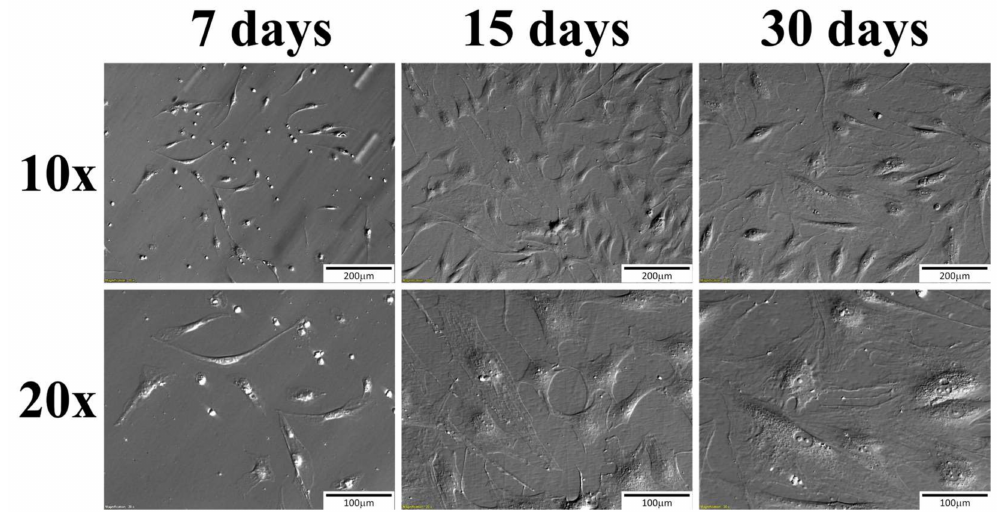
Figure 6. Photos of cell cultures prior to the material collection taken under an inverted microscope using relief